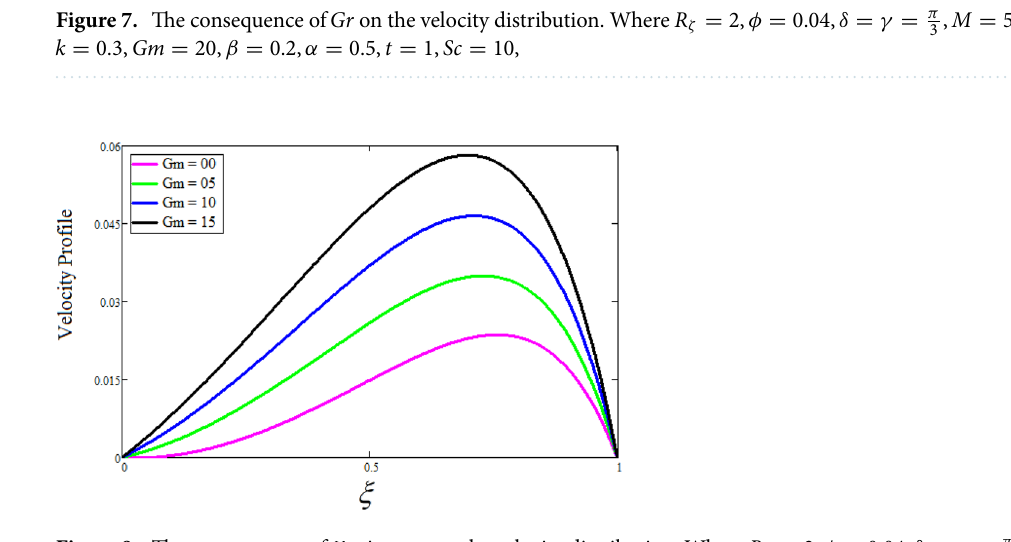
Figure 8. The consequence of Gm impact on the velocity distribution. Where R ζ = 2, φ = 0.04, δ = γ = π 3 , M = 5, k = 0.3, Gr = 10, β = 0.2, α = 0.5, t = 1, Sc =